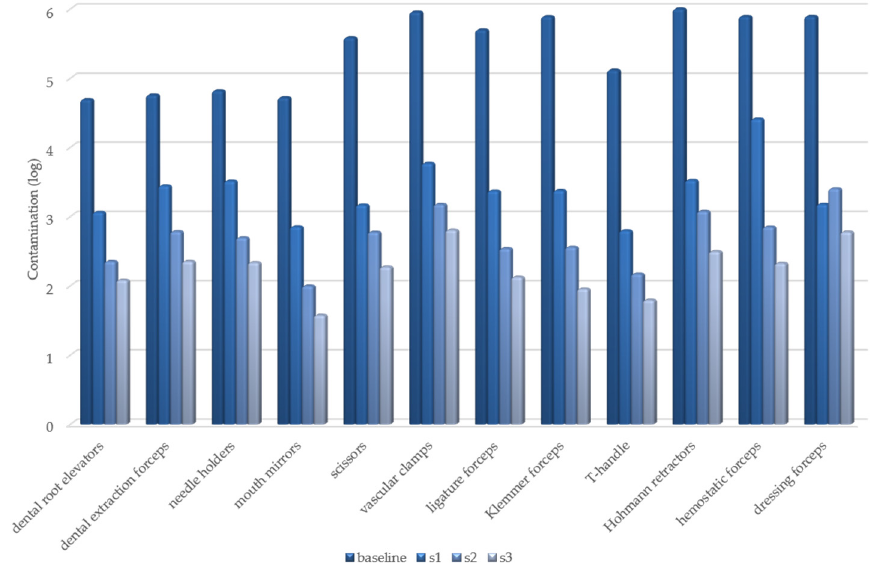
Figure 1. Test point 1: variation in degree of contamination in each cleaning step.